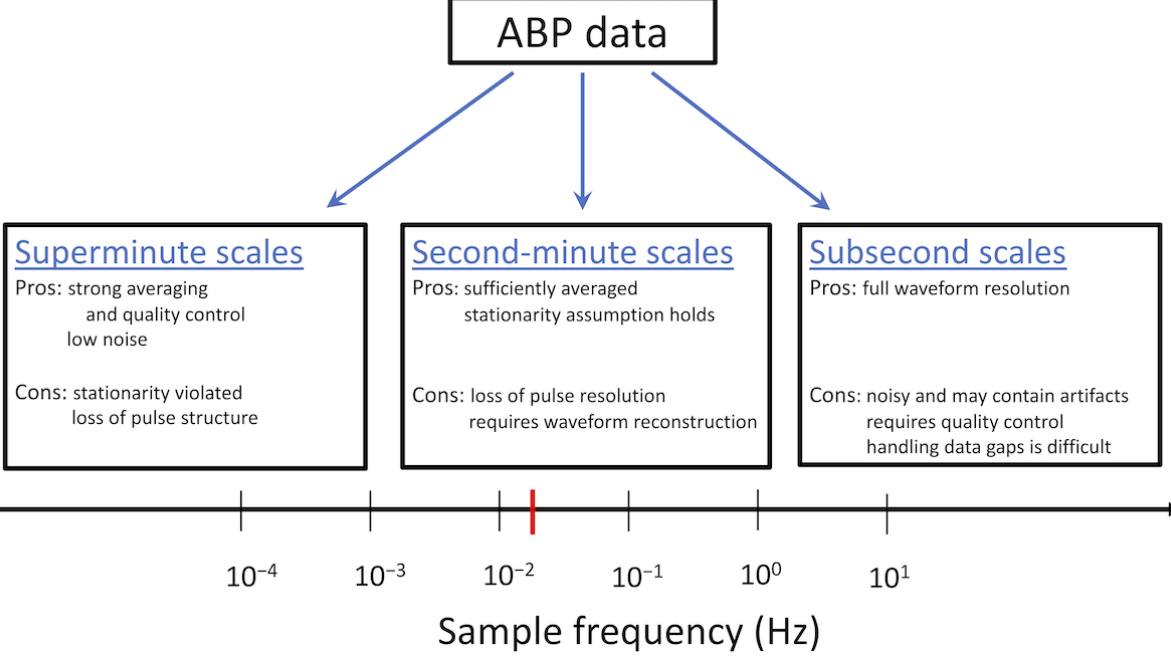
Figure 4. Timescales of ABP inflow data. The complex models can run on data from any part of the sampling spectrum. Simple models require pulsatile inflow from the rightmost portion of the scale (above about 10 Hz), which may not be typically available. The central scale is desirable for hour-scale applications, as this resolution both qualitatively minimizes computational overhead and supports parameter stationarity assumed in the regressive single-compartment models. The quaque 1-min data sampling frequency is indicated in red. The left-most scale offers strong smoothing and low noise but fails to resolve pulsatile waveform and violates assumptions of the simple models. ABP: arterial blood